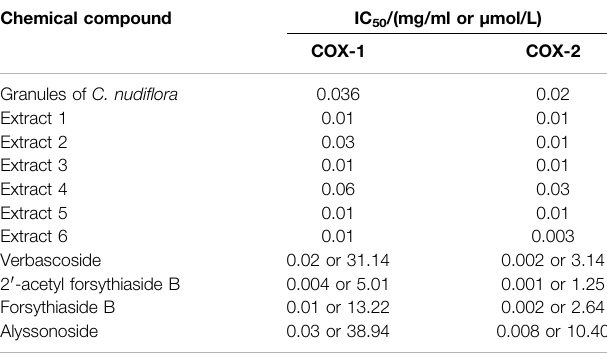
TABLE 7 | IC 50 effect on cyclooxygenase (COX-1 and COX-2). Chemical